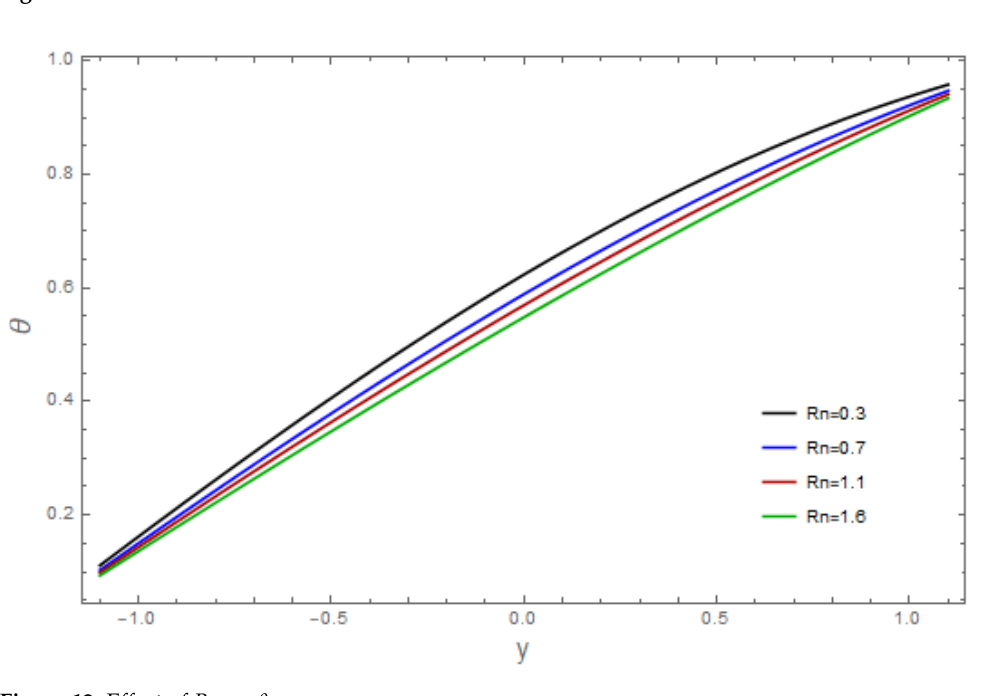
Figure 12. Effect of 𝑅𝑛 on 𝜃 .